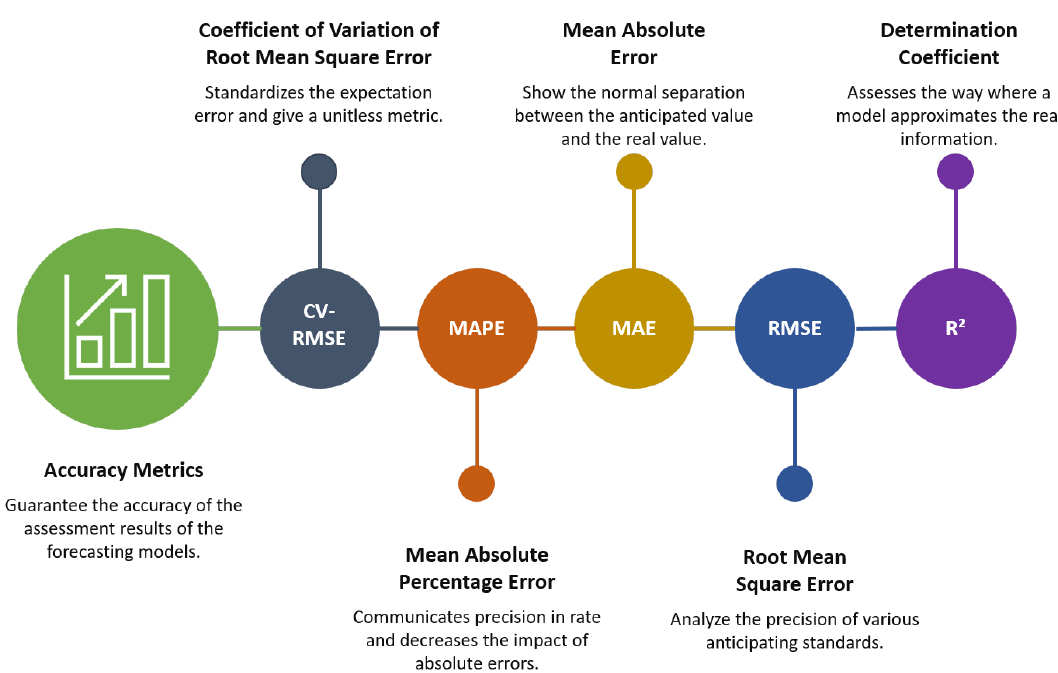
Figure 4. Accuracy metrics to validate forecasting models.